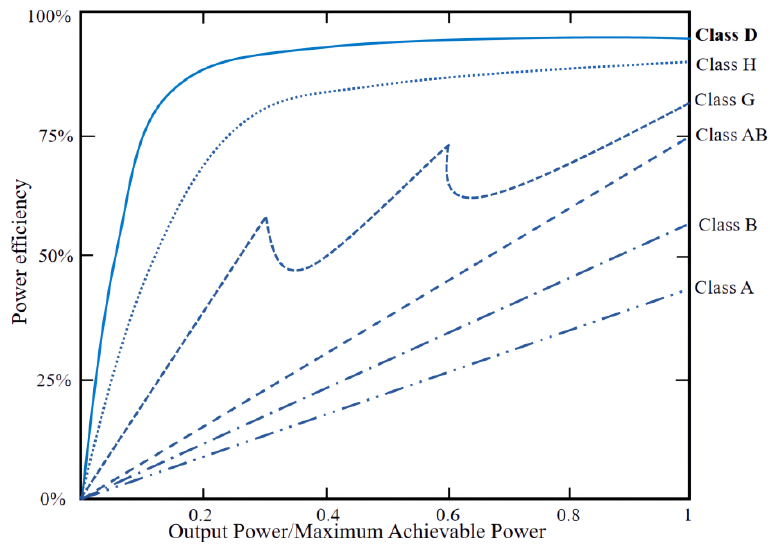
Figure 1. Efficiency comparison of each amplifier [2,8,9].